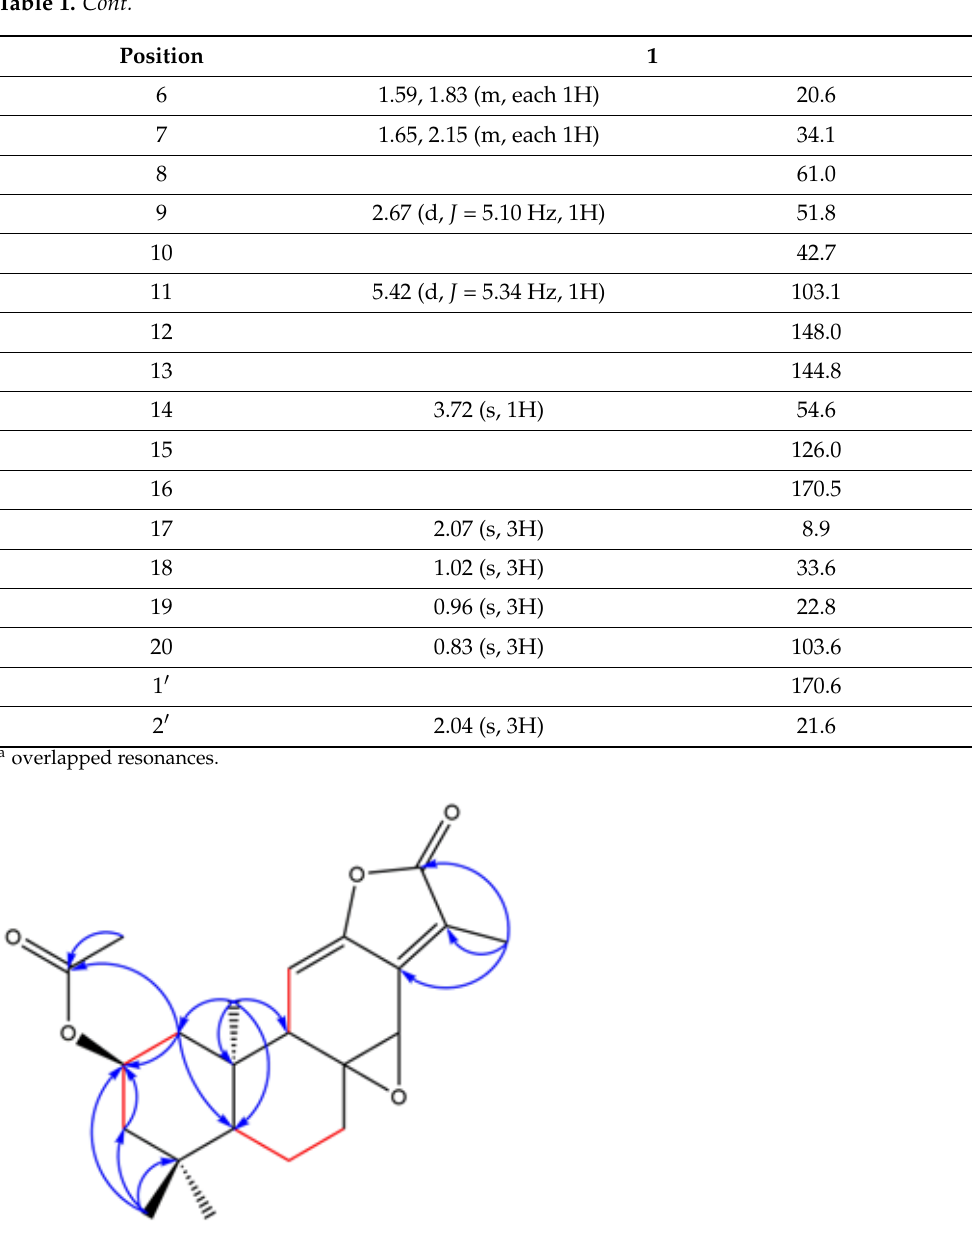
Figure 1. The key HMBC (H → C) and 1 H – 1 H COSY (H — H) correlations of compound 1 .